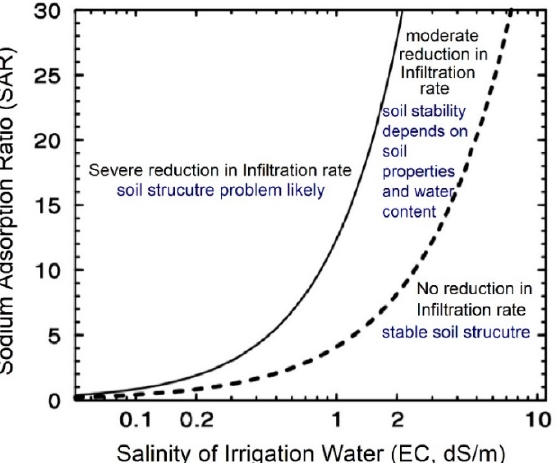
Figure 1. The relationship between soil salinity and sodicity on soil structure and infiltration (based on Hanson et. al, 1999 [92] and ANZECC, 2000 [93]).